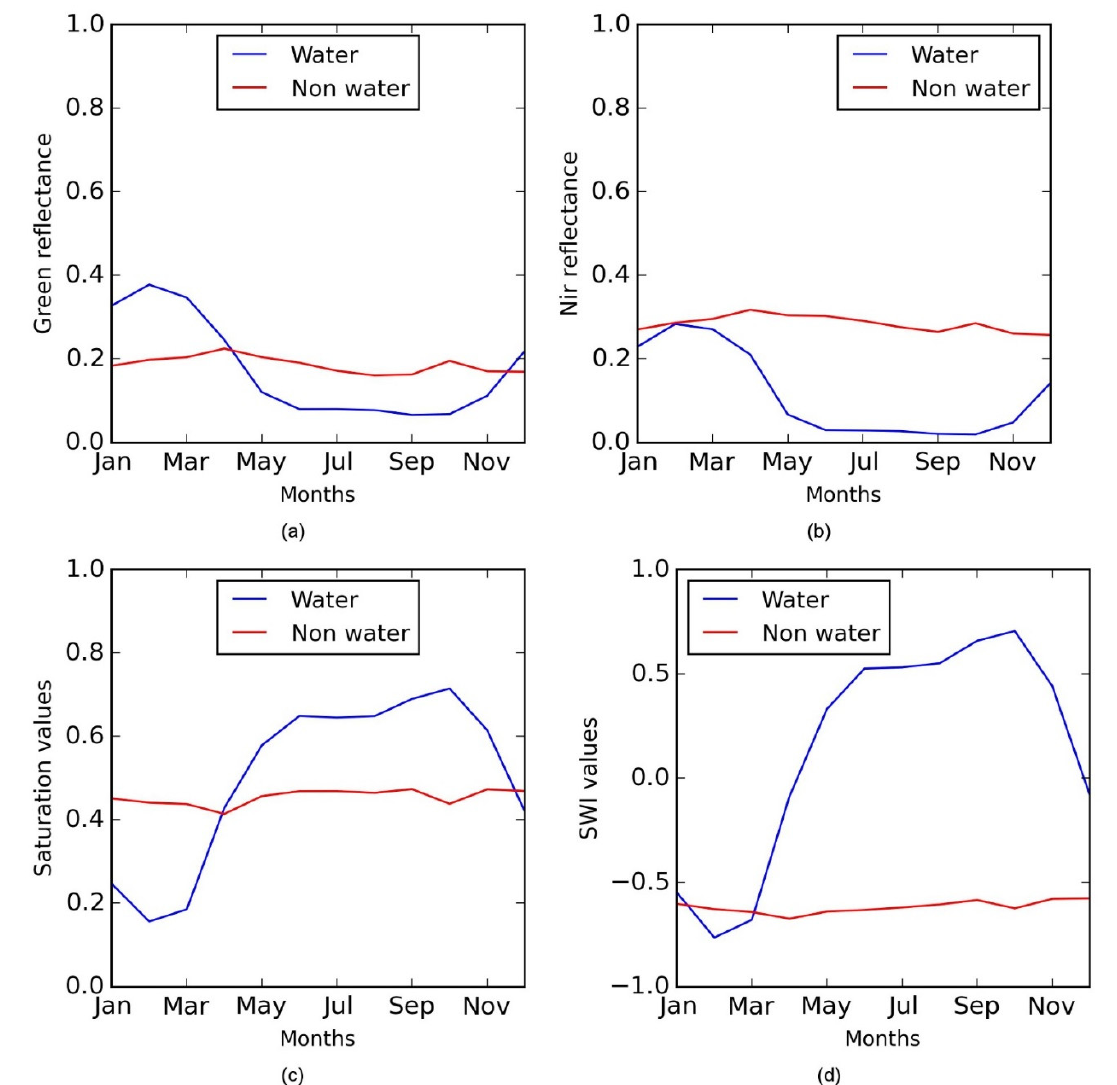
Figure 8. Monthly variation of different parameters over the water and non-water areas in a dry region: ( a ) Green reflectance, ( b ) Near infrared reflectance, ( c ) Saturation values, ( d ) Superfine Water Index (SWI)